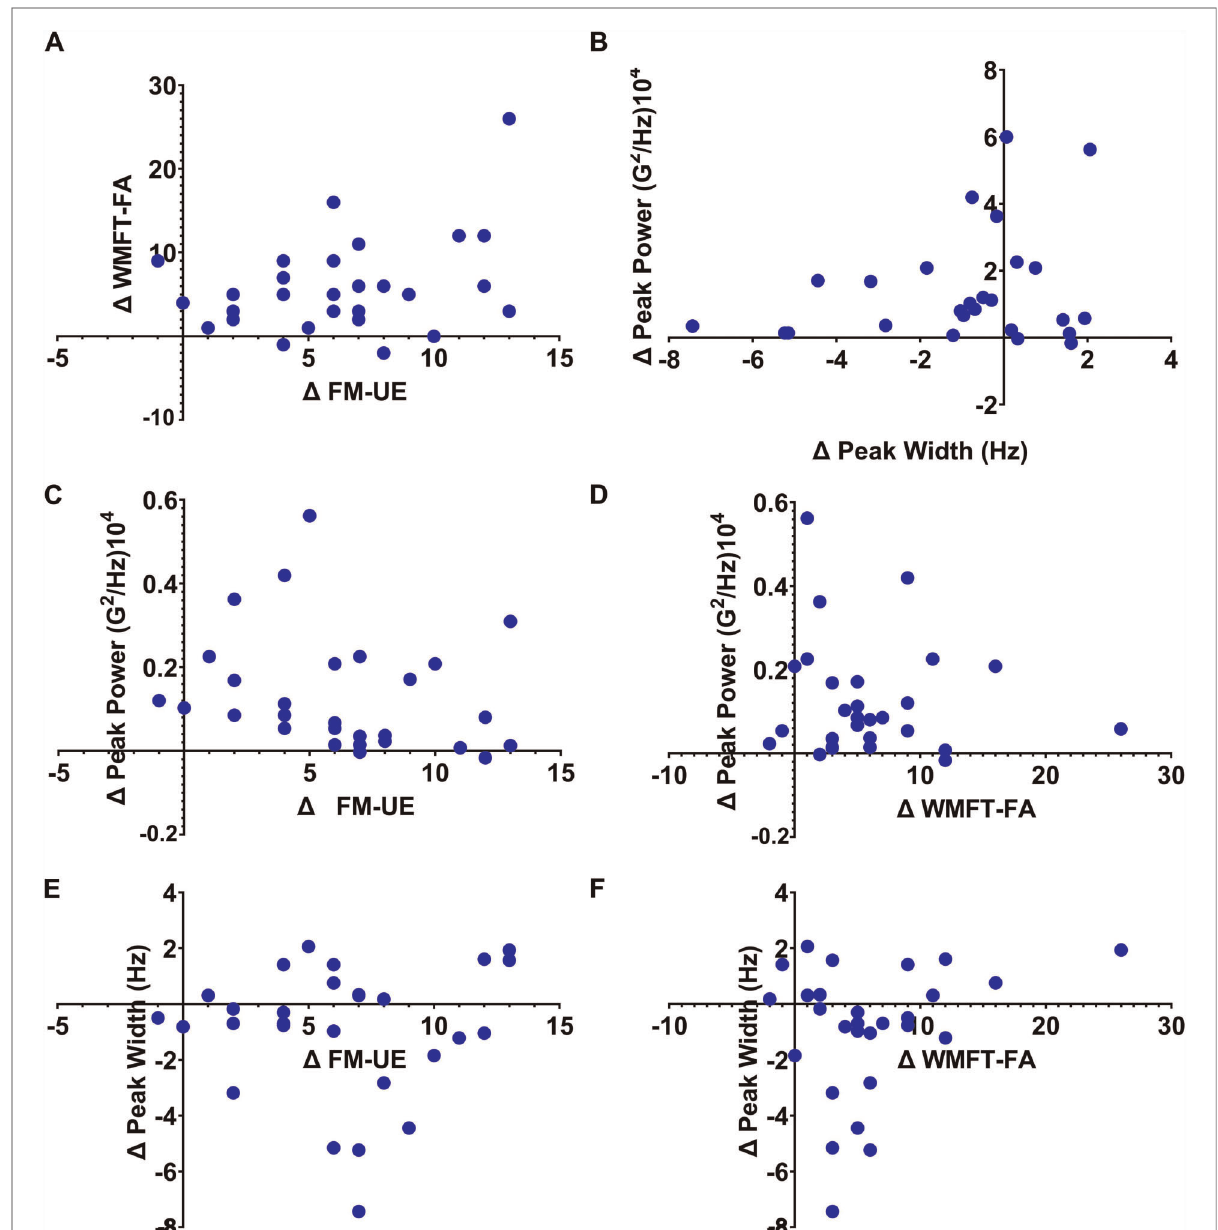
FIGURE 4 The results for relationship between measures. The relationship between WMFT and FM-UE scores (i.e., Panel A ) as well as between Δ peak powerand Δ peak width (i.e., Panel B ) are shown. Δ peak power and Δ FM-UE and Δ WMFT are shown in panels C and D , respectively. Lastly, Panels E and F show the relationship between Δ peak width and Δ FM-UE and Δ